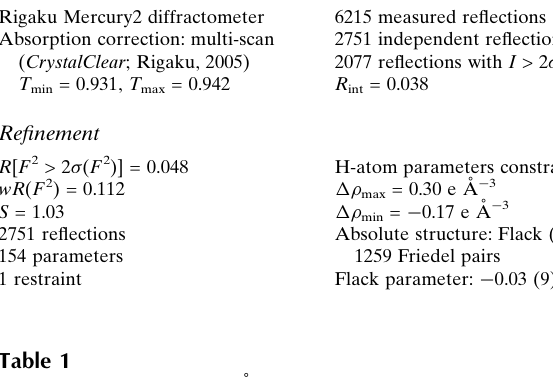
Hydrogen-bond geometry (A˚ , (cid:3)